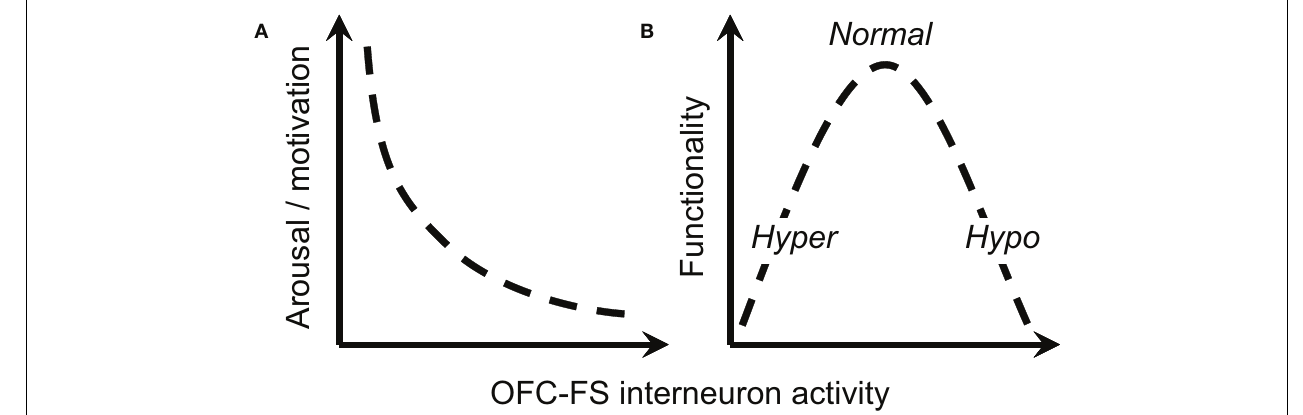
FIGURE 8 | Proposed role of OFC interneurons in regulation of behavior. (A) The activity of OFC–FS type interneurons is negatively correlated with level of arousal or motivation, as indicated by correlations between NS1 fi ring and response latency. (B) An intermediate level of activity of OFC–FS interneurons is